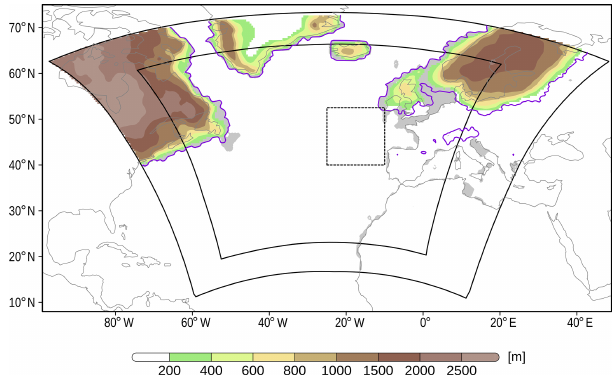
Figure 1. WRF model domains (outer solid box: 50km grid spac- ing; inner solid box: 12.5km grid spacing), ice sheet heights (m) (coloured) and extents (purple line), land–sea mask (additional land areas grey) as obtained from PMIP3; the target area for cyclone de- tection is marked by the dotted